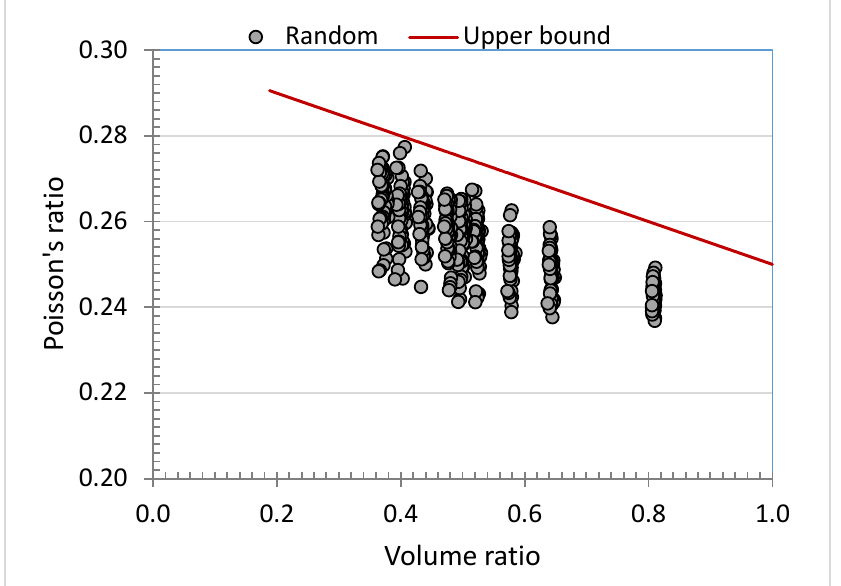
Fig. 13. Poisson’s ratios versus volume ratio of random stone